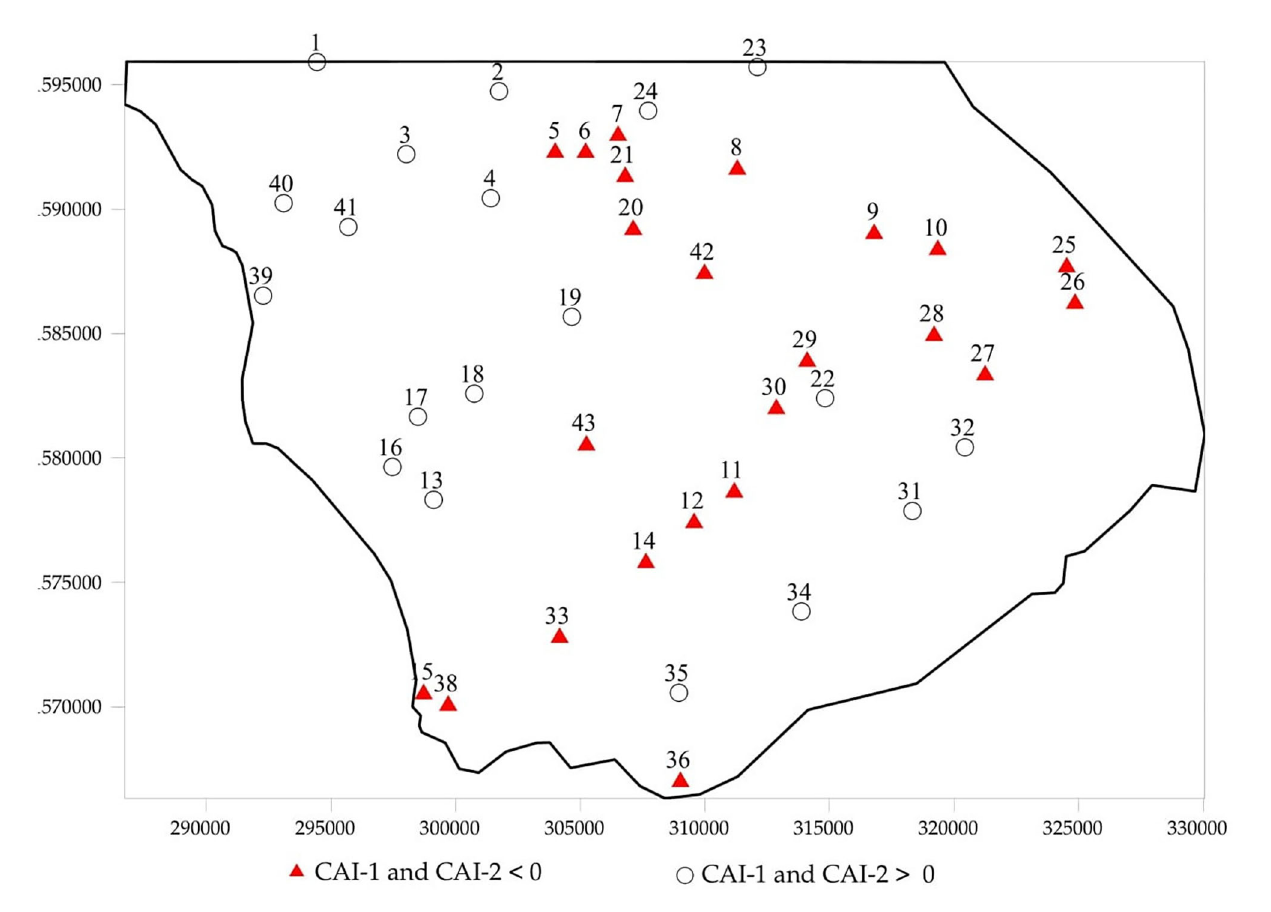
FIGURE9 Regional distribution of Chloro-Alkaline Indices in the study area.